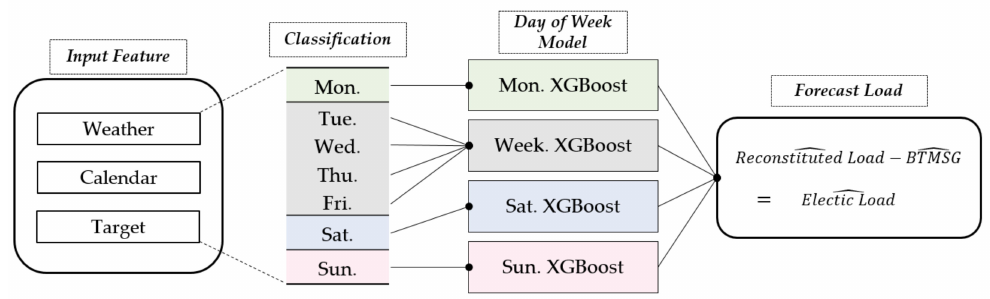
Figure 9. Load forecasting process of the DoW XGBoost model.